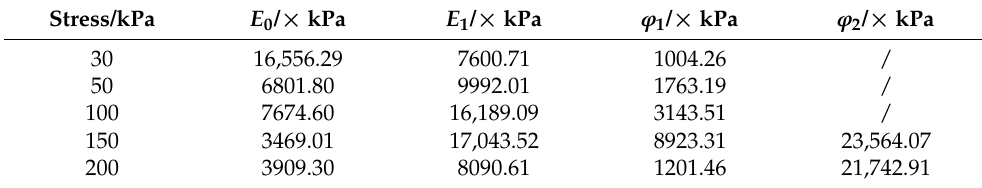
Table 2. Soft marine soil creep model parameters at each stress level.